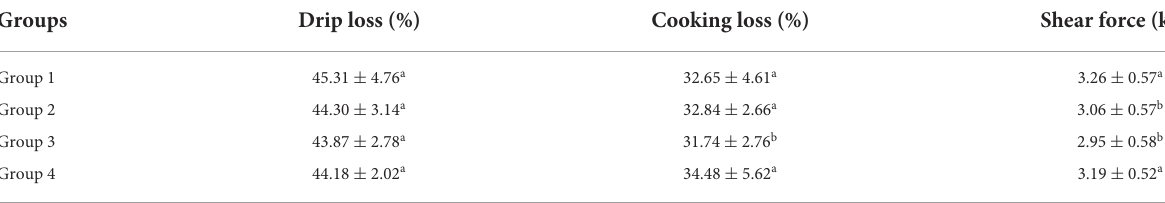
TABLE 3 Comparison of meat qualities (mean ± SD) among four